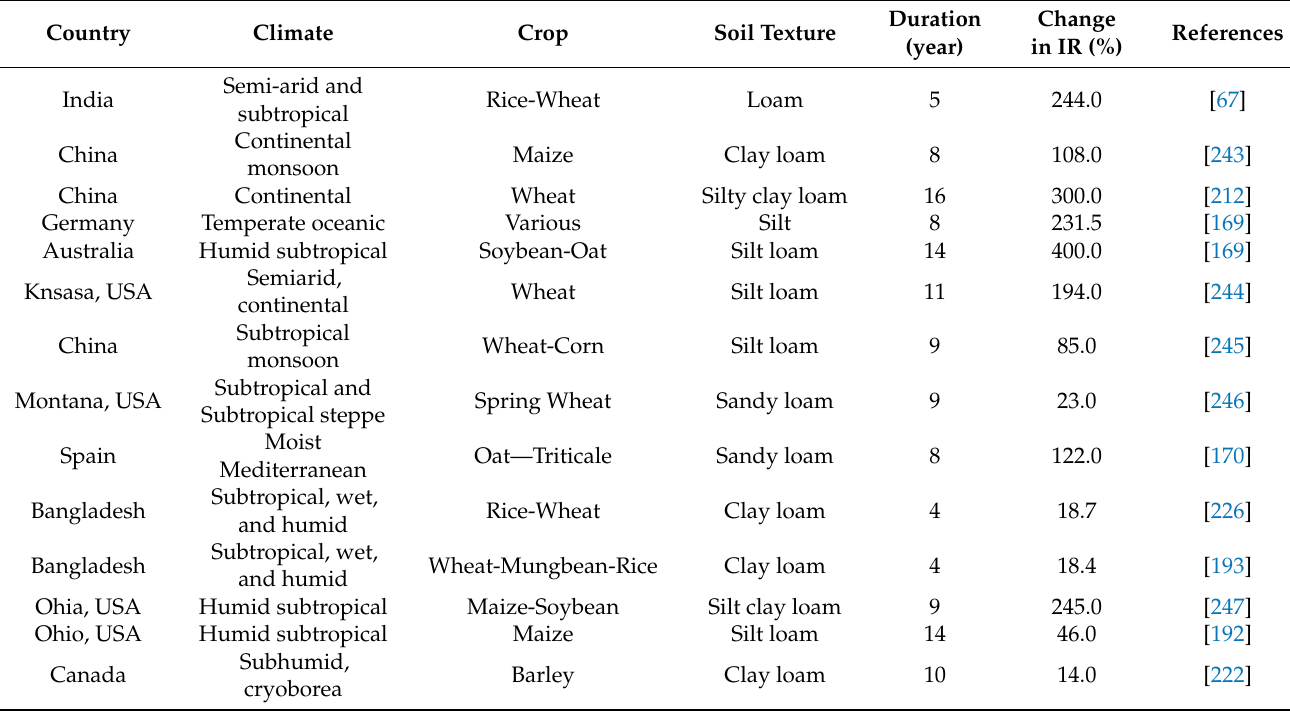
Table 3. Examples of the increase in soil infiltration rate (IR) following the adoption of conservation agriculture practices (zero or minimum tillage + crop residue retention, with or without crop